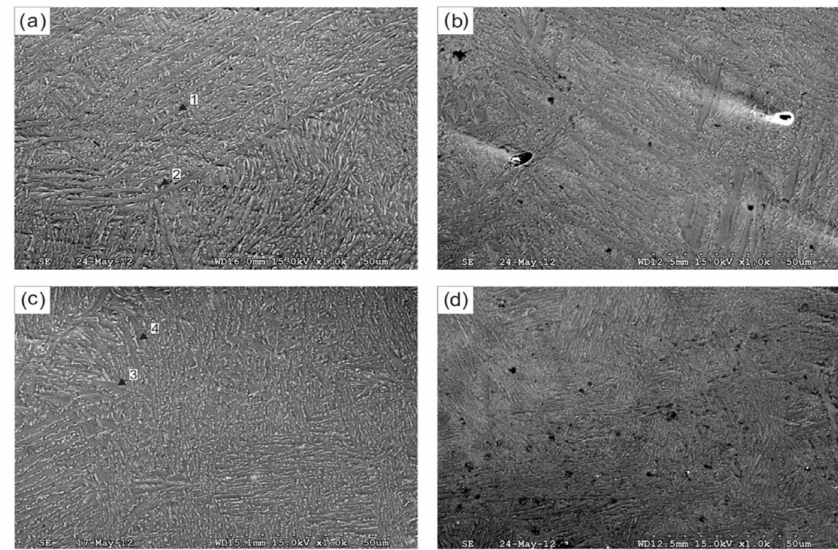
Figure 33. Microstructures under SEM after potentiodynamic testing in ( a ) Ti 7 Cu, ( b ) Ti 7 CuSn,